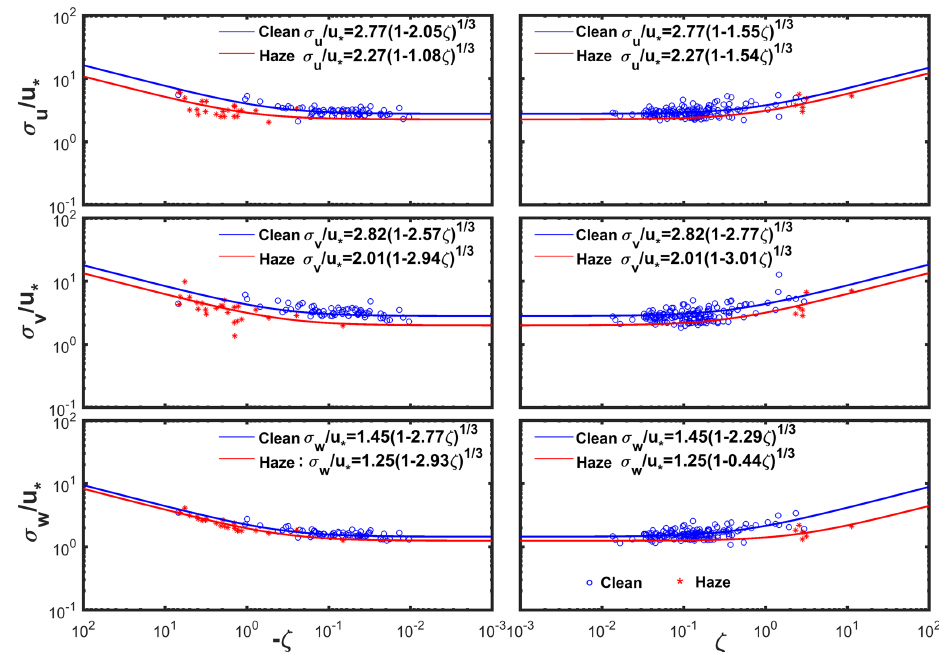
Figure 9. Normalized standard deviations in wind speed in the horizontal and vertical directions ( σ u /u ∗ , σ v /u ∗ , and σ w /u ∗ ) as functions of the stability parameter ζ . The red (blue) line in the figure represents the results under polluted (clear) weather conditions. Observations marked with ∗ ( ◦ ) were made under polluted (clear) weather conditions.